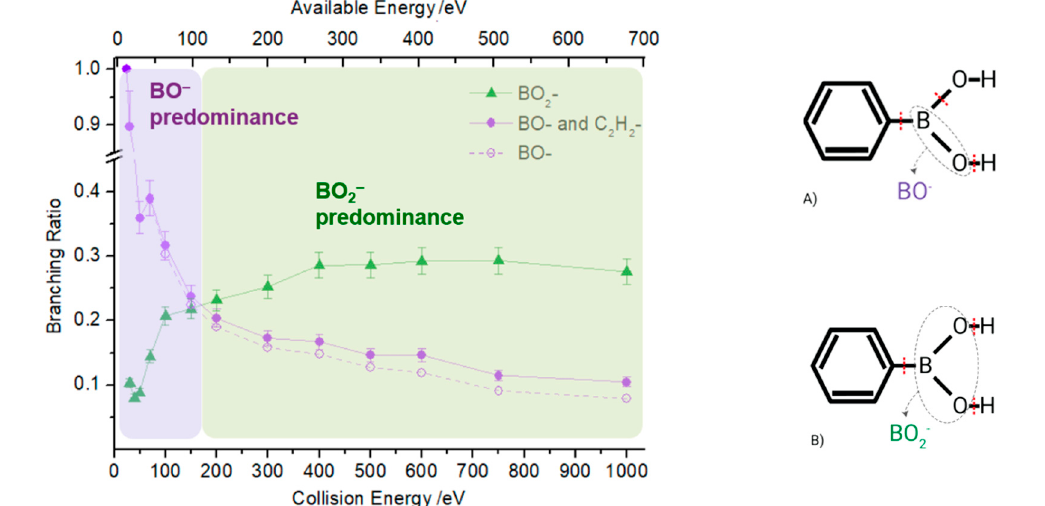
Figure 4. Left: PBA branching ratio of BO − and BO 2 − ions as a function of the collision energy. Green lines with full triangles represent BO 2 − , while purple lines with full circles indicate BO − with the contribution of the isobaric fragment C 2 H 2 − . The dashed line represents the BO − branching ratio without the contribution of C 2 H 2 − and was obtained based on the natural abundance of heavier isotopic species ( 11 BO − ), not contaminated by any other fragment. Right: schematics of bond rupture leading to BO − ( A ) and BO 2 − ( B ) formation.